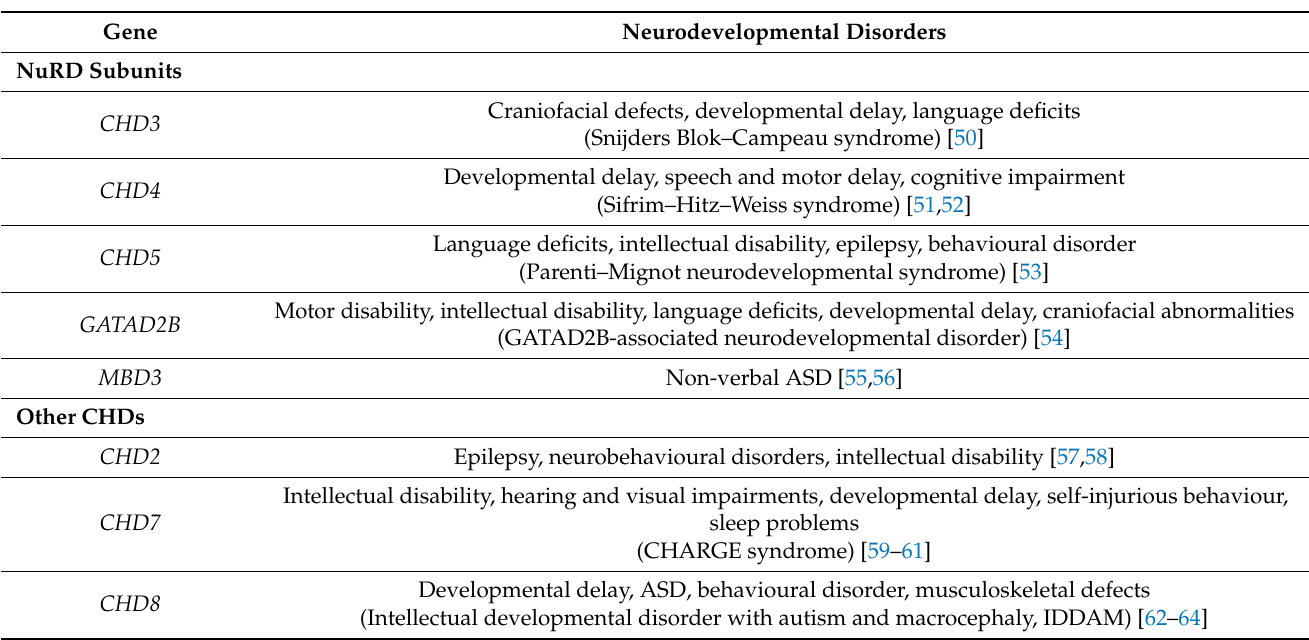
Table 1. Summary of NuRD and CHD genes associated with neurodevelopmental